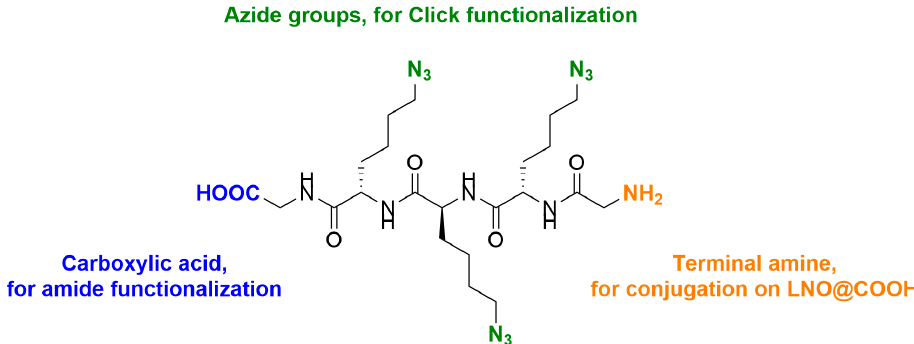
Figure 3. Structure of the designed Talys peptide (tri-azidolysine, Gly-Alys-Alys-Alys-Gly).